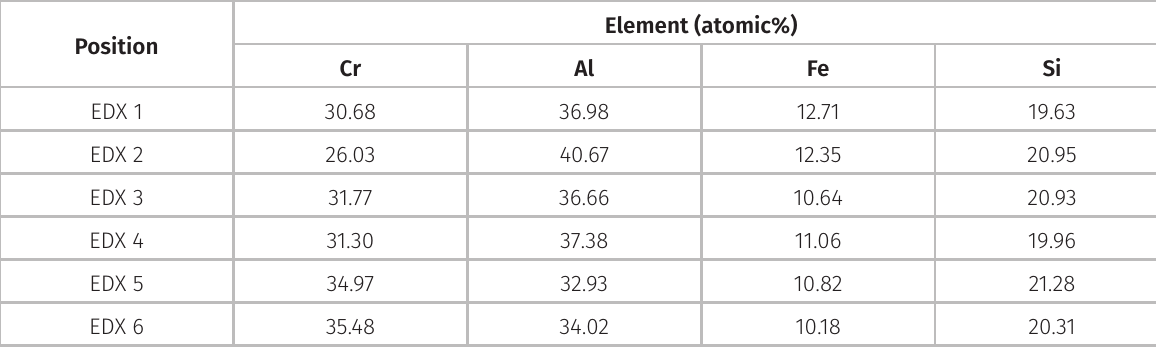
Table III. EDX analysis of the coated substrate for the position 1-6 marked in Figure 3a and Figure 3b. Element (atomic%) Position Cr Al Fe